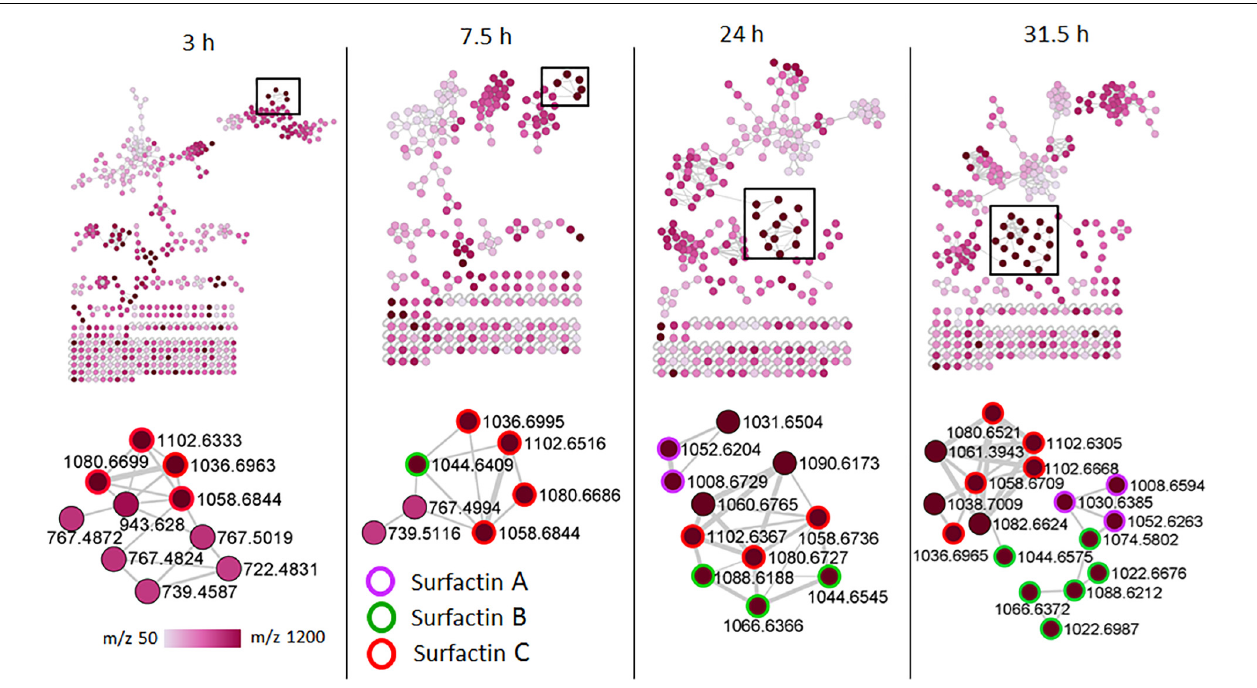
FIGURE 5 | Molecular networking of positive electrospray ionization (ESI + ) MS/MS spectra obtained from consortium over time. The zoom-in snaps show that the presence of lipopeptides (surfactins) varies depending on the bacterial growth phase. The nodes are colored based on the acquired mass range ( m/z 50–1,200 Da) of the precursor ions: light pink nodes represent the smallest masses whereas the dark purple nodes represent the largest